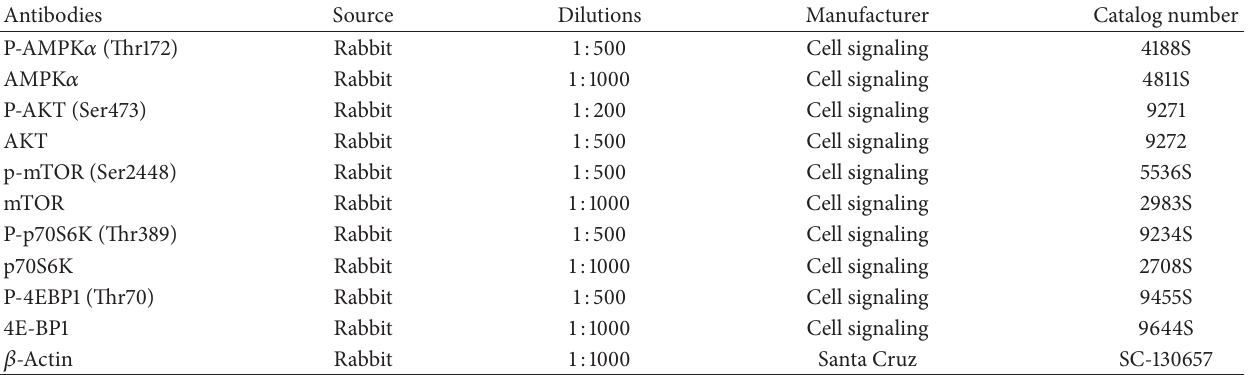
Table 1: Antibodies, their concentrations and manufacturers in the present studies.